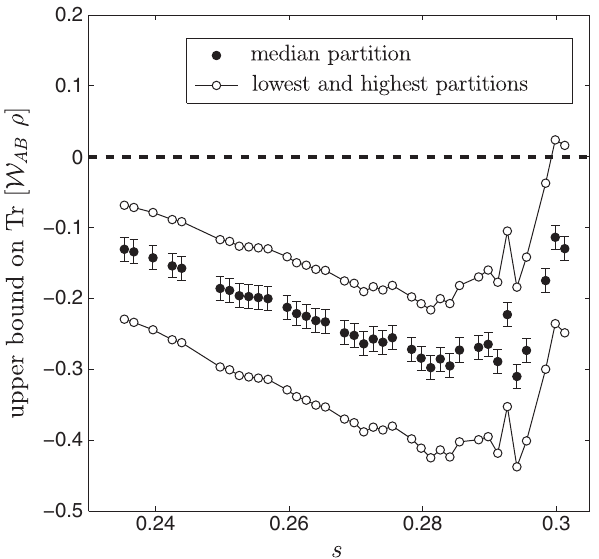
ρ (cid:1) versus s for FIG. 5. Upper limit of the quantity Tr ½ W AB several bipartitions A − B of the eight-qubit system. When this quantity is less than 0, the system is entangled with respect to this ρ (cid:1) for bipartition. The solid dots show the upper limit on Tr ½ W AB the median bipartition. The open dots above and below these are derived from the two bipartitions that give the highest and lowest ρ (cid:1) , respectively. For the points at s > 0 . 3 , upper limits on Tr ½ W AB the measurements of P 1 and P 2 do not constrain ρ enough to certify